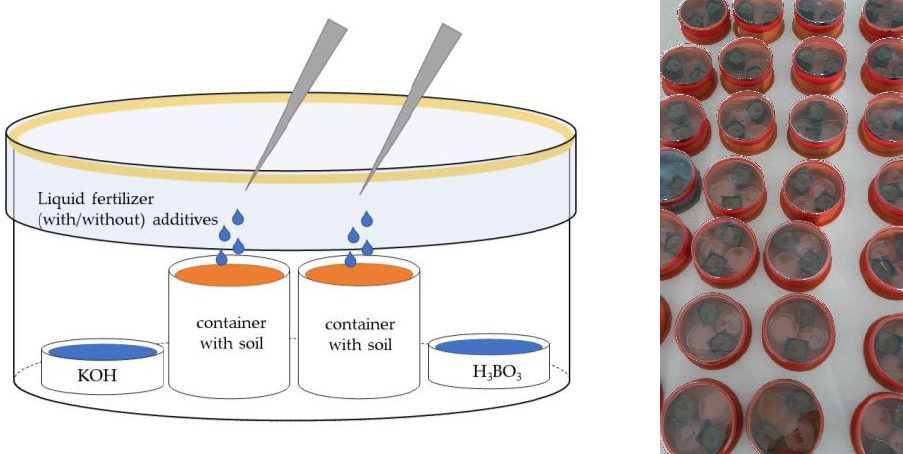
Figure 5. Hermetic chamber to quantify NH 3 volatilization from fertilized surface soil. The amount of volatilized ammonia was calculated according to the consumed sul- phuric acid solution, as it is described in Equation